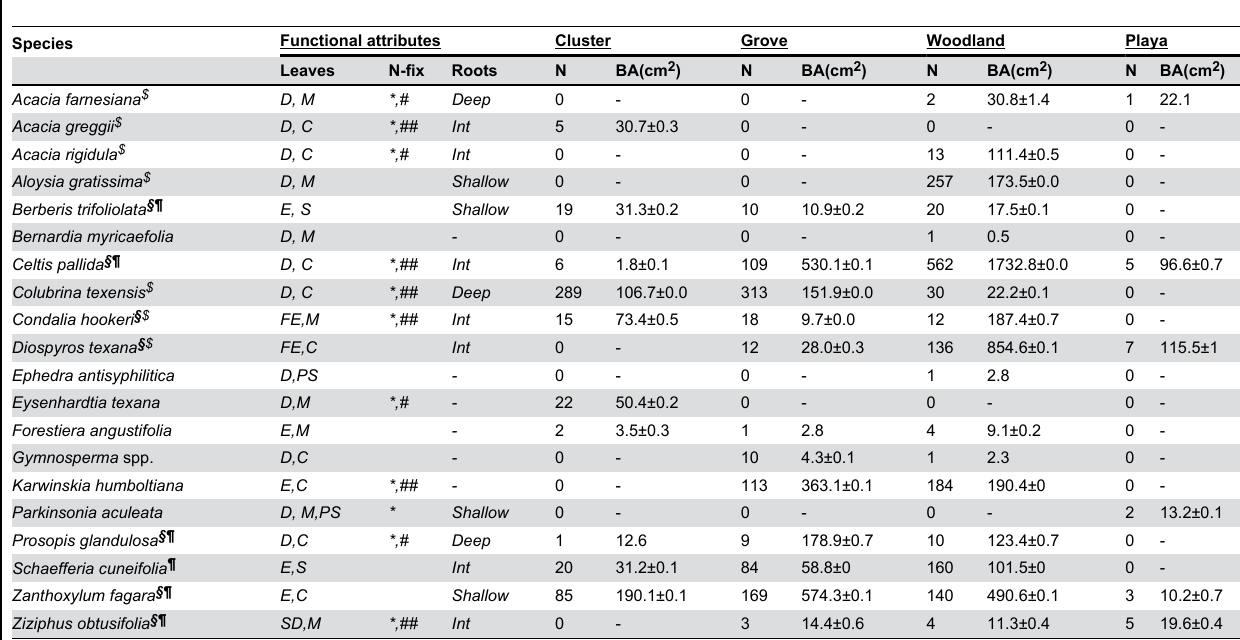
Table 3. Occurrence (N) and mean basal area (BA, mean + SE; cm 2 m -2 ) of shrub-stature species within a 2-m wide belt transect (Figure